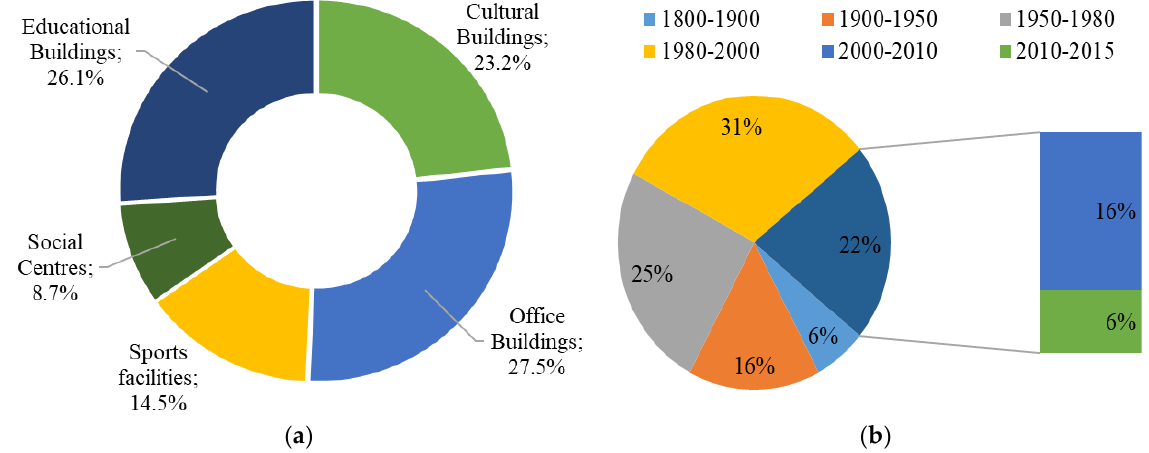
Figure 4. ( a ) Distribution of the buildings by building typology ( b ) by year of construction. The EPCs show that 51% of the buildings have an energy label F or worse (in an A–G scale) in terms of total CO 2 emissions (Figure 5a). Figure 5b shows that the predominant fuel used is light fuel oil (in 45% of the total heated area) so there is a significant potential of CO 2 emissions reduction with the replacement of the heating system.